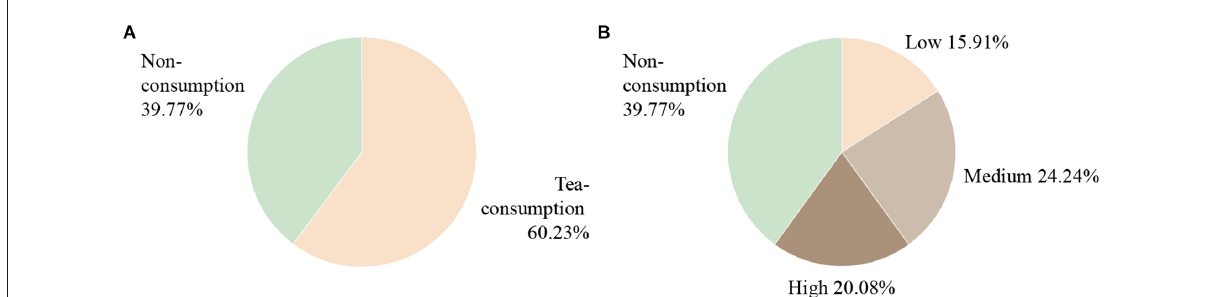
FIGURE2 Participants’ grouping profile. (A) First, the 264 subjects were divided into two groups for preliminary analysis, including 105 cases (39.77%) for the non-consumption group and 159 cases (60.23%) for the tea-consuming group. (B) Furthermore, the tea-consuming group was divided into “low, medium, and high” groups based on the consumption frequency and daily volume of tea for subgroup analysis. There were 42 cases (15.91 %) in the low group, 64 cases (24.24%) in the medium group, and 53 cases (20.08%) in the high group.